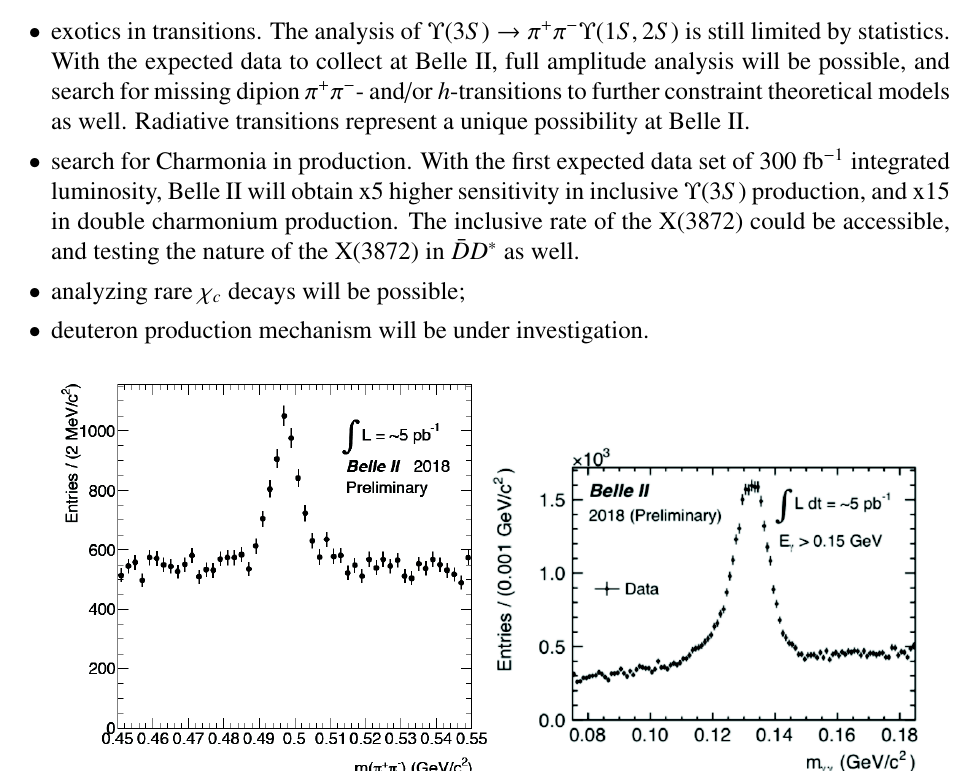
nominal mass; (right) invariant s